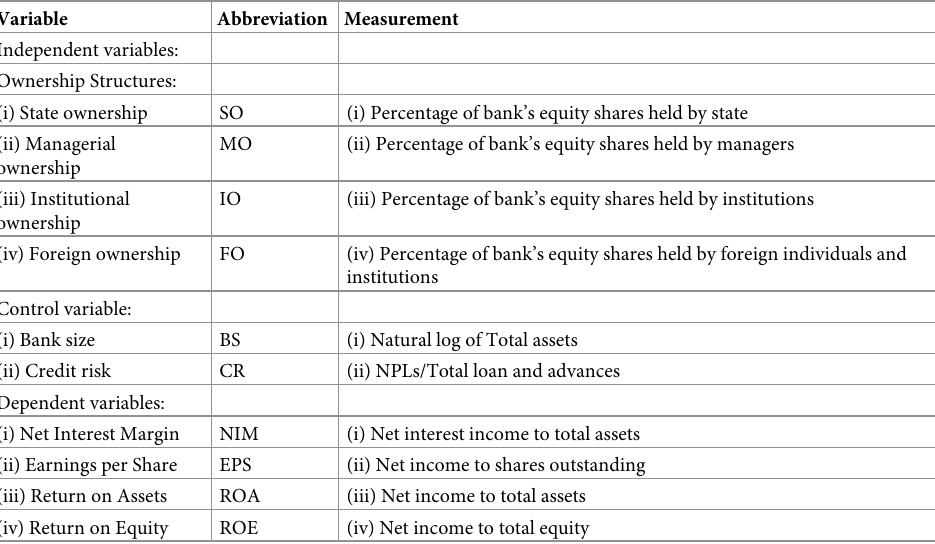
Table 1. Operationalization and measurement of